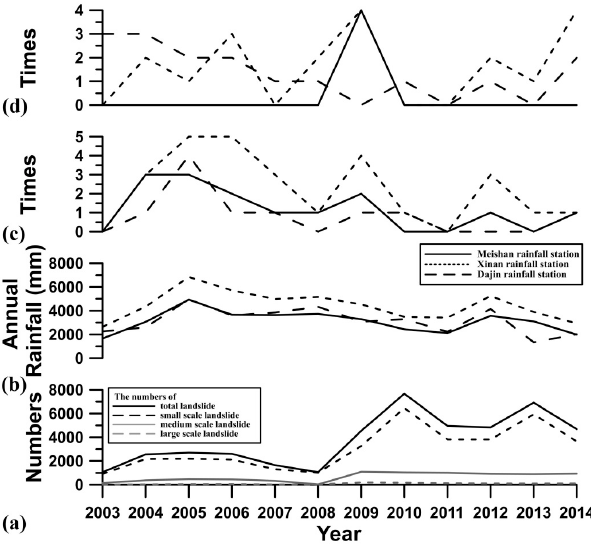
Figure 8. The numbers of landslide ( a ), including total landslide (black line), small scale landslide (black dash line), medium scale landslide (grey line), and large scale landslide (grey dash line) and annual rainfall ( b ), the times of R D > 350 mm (the standard of heavy rainfall, ( c ), and the times of R I > 70 mm/h ( d ) according to the records of Meishan (black line), Xinan (black point line), and Dajin (black dash line) from 2003 to 2014 in the LRW.